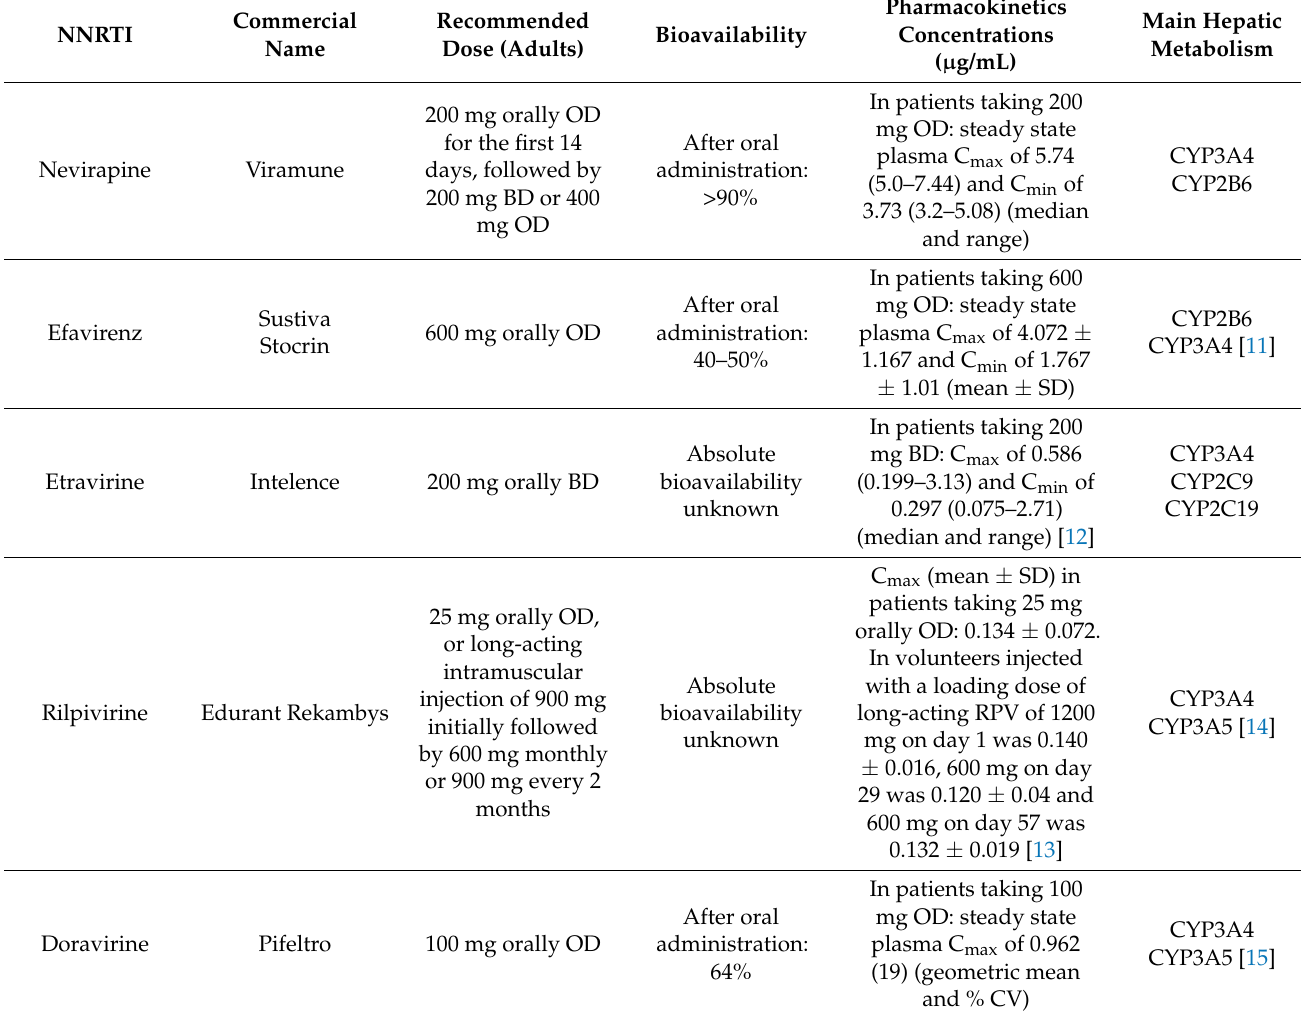
Table 1. Summary of the basic pharmacological characteristics of each NNRTI. If not specified, data are obtained from European Medicines Agency (EMA) product information. OD: once daily; BD: twice a